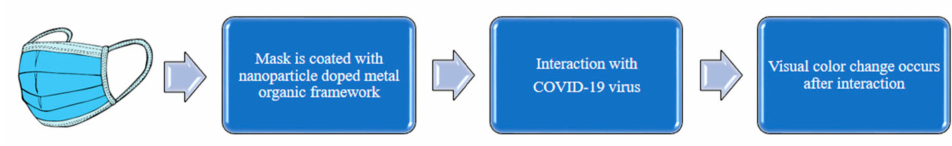
Figure 10. Workflow of a wearable